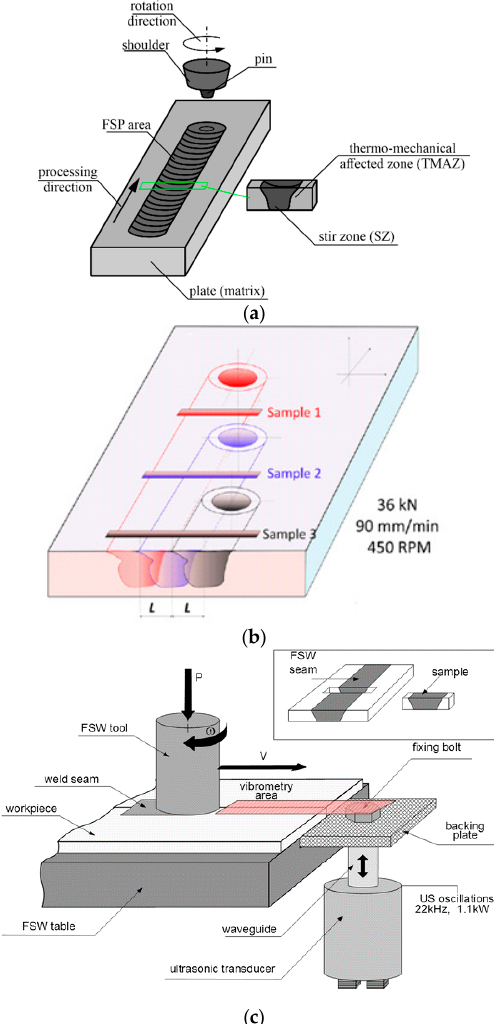
Figure 1. Schematic diagram of the FSP process: ( a ) multi-pass FSP process ( b ) (reproduced from [42], with permission from Springer, 2019) and FSW process with ultrasound assistance ( c ) (reproduced from [94], with permission from Springer, 2017).